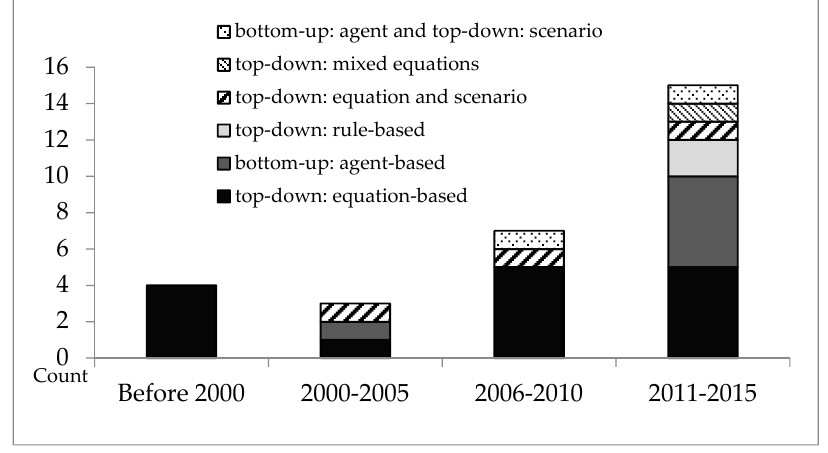
Figure 5. Trend of modelling techniques.